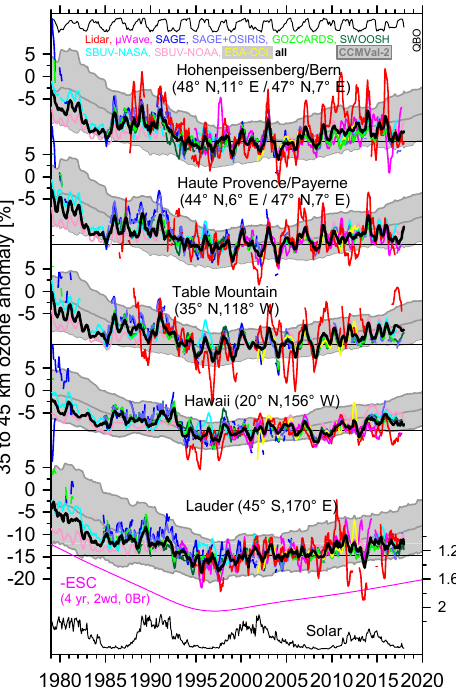
Figure 5. The essential synergism of NDACC measurements with data from satellites. The grey area shows the range of model sim- ulations from the CCMVal-2 initiative. Also shown at the top and bottom are sources of expected natural variability (QBO and solar cycle, respectively) and the evolution of man-made ESC (effective stratospheric chlorine, magenta line; note the reversed scale on the right). The data are used for verifying the success of the Montreal